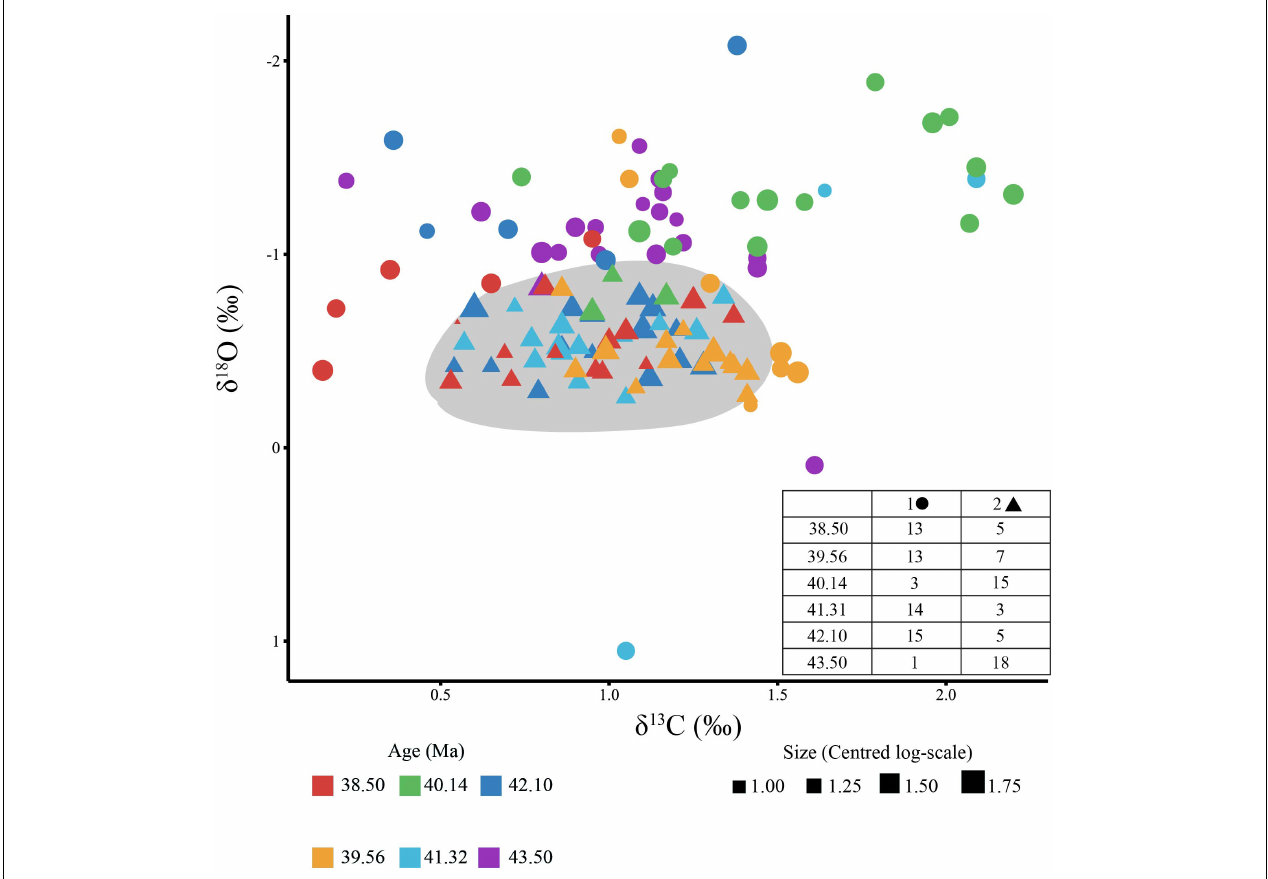
FIGURE 4 | Cross plot of carbon versus oxygen isotopes for individual Subbotina analysis. Individual point size represents the size (area) of each individual on a log scale. The symbol (triangle vs. circle) indicates the cluster that each individual was assigned to following cluster analysis. Circles represent cluster 1 and consist primarily of individuals from 40.14 and 43.50 Ma as highlighted in the table inset into the figure, while triangles represent cluster 2. The number of individuals in each time slice assigned to each cluster is shown in the inset table. The gray area visually represents cluster 2 as identified by the